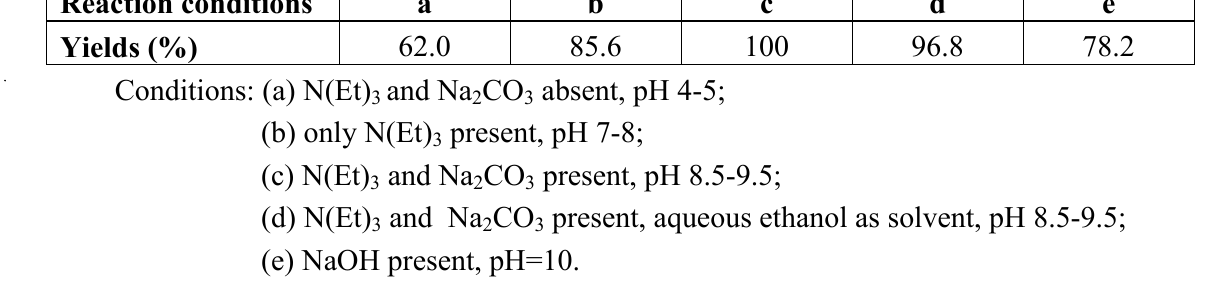
Table 1. Yields of (Ph